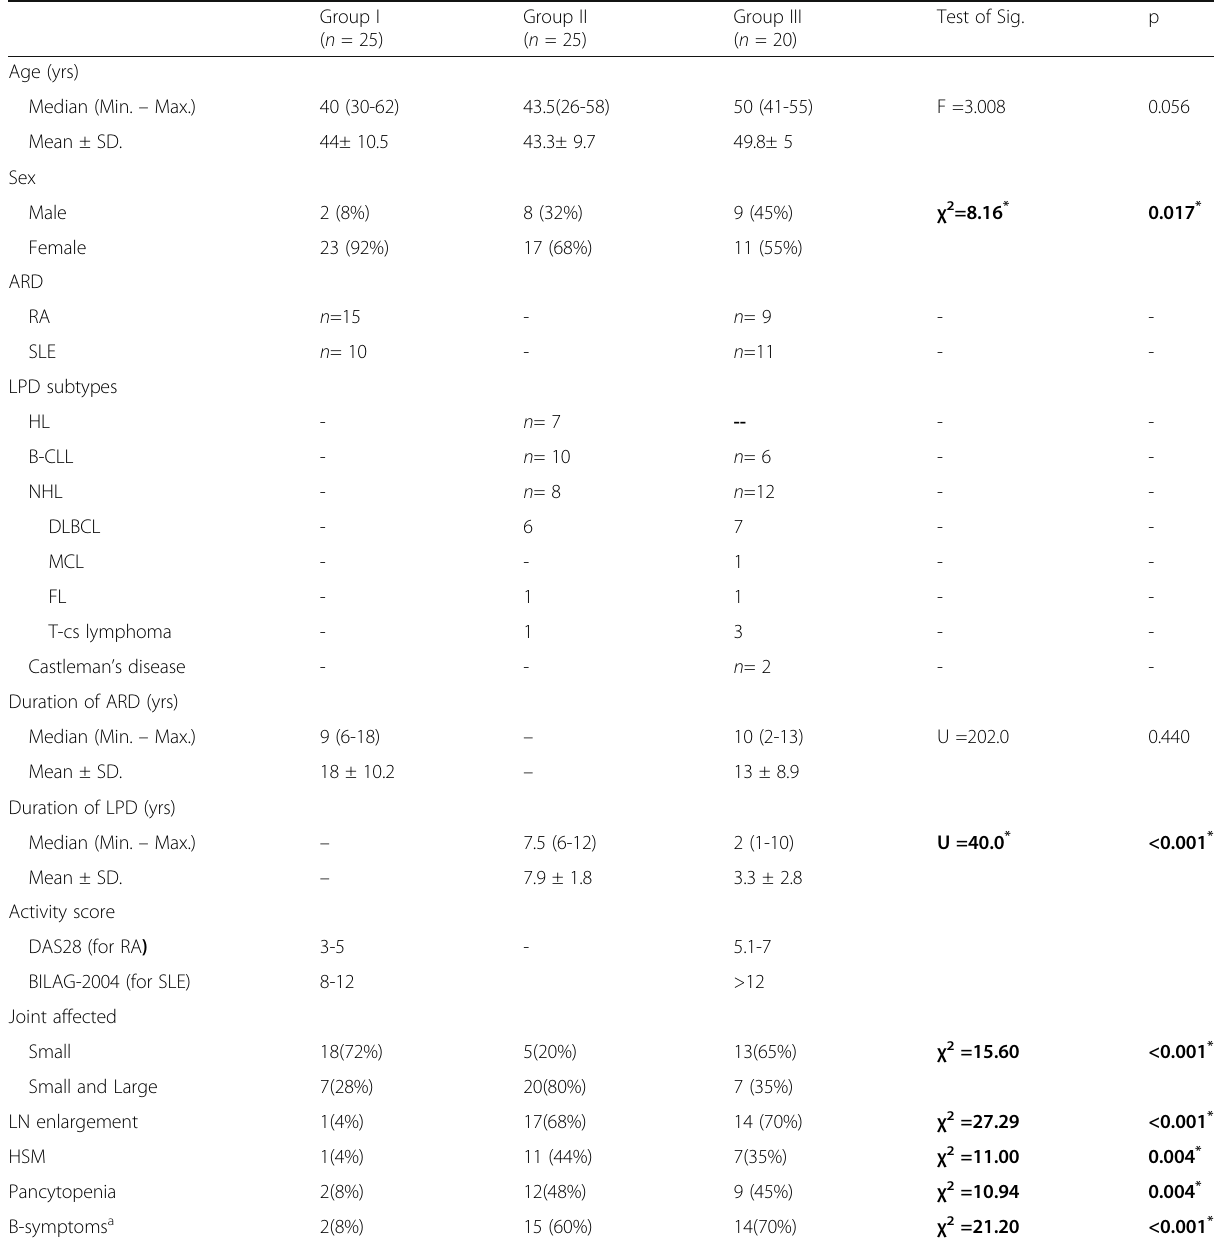
Table 1 Demographic data of the three studied